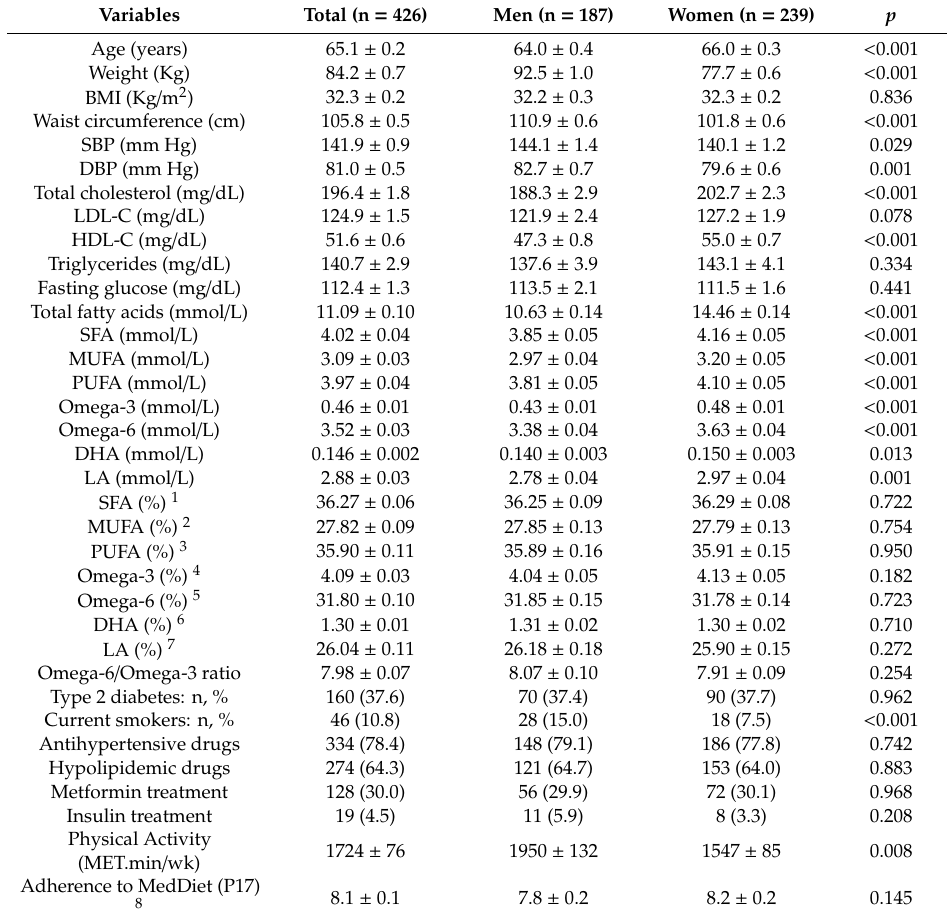
Table 1. Demographic, clinical, lifestyle, and biochemical characteristics of the study participants at baseline according to